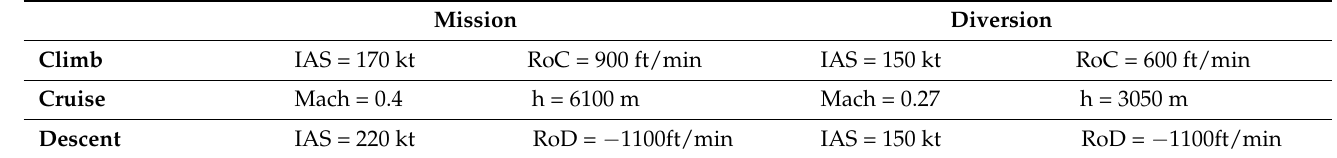
Table 2. Conditions for the flight programmes for mission and diversion.